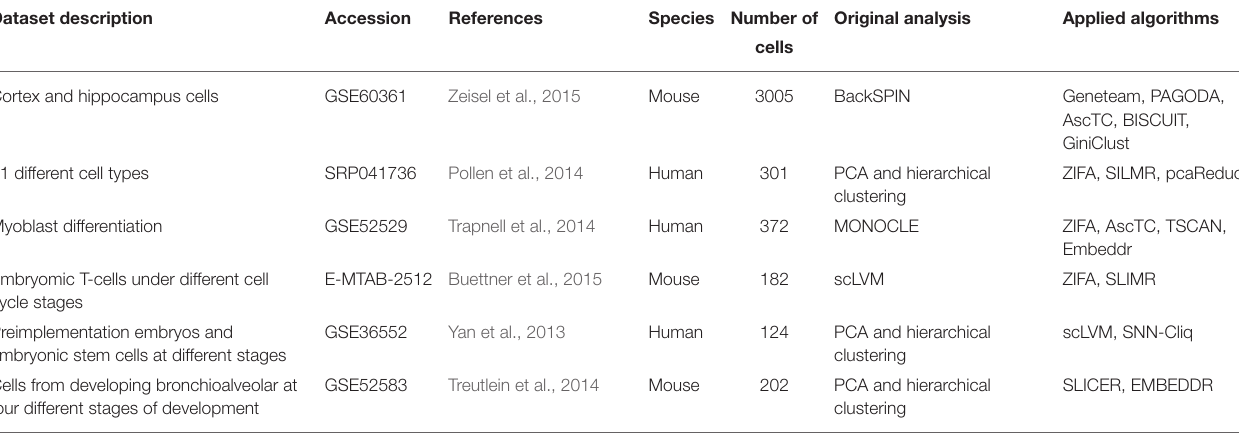
TABLE 2 | Description of the main datasets for subpopulation and module detection analysis. Dataset